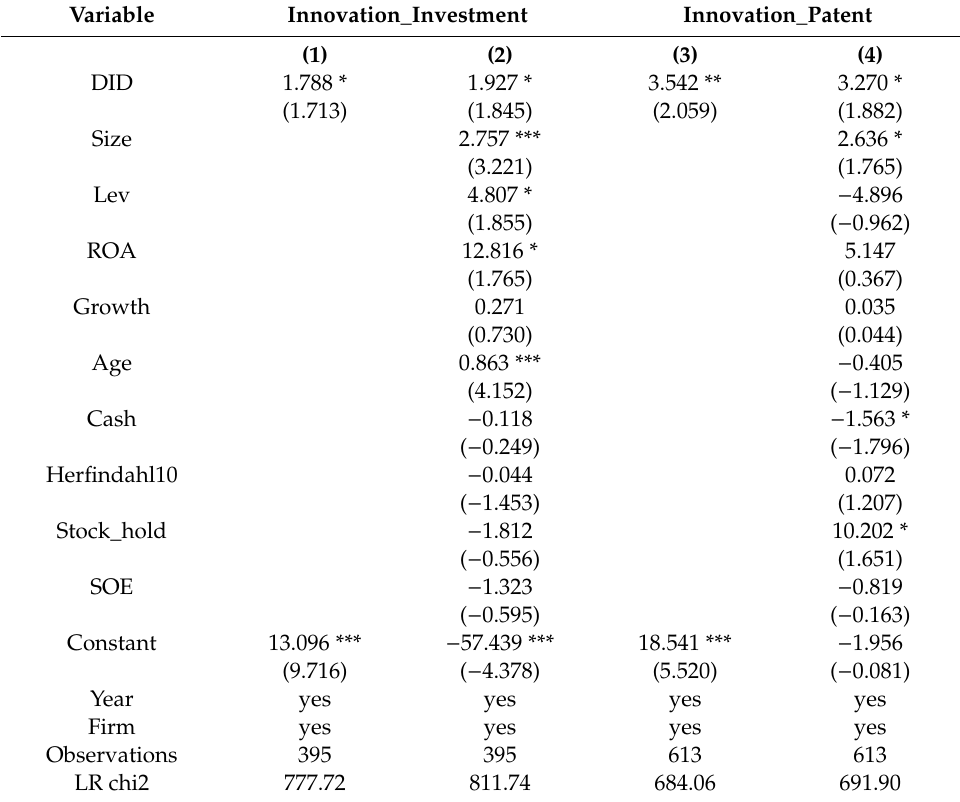
Table 4. Regression analysis